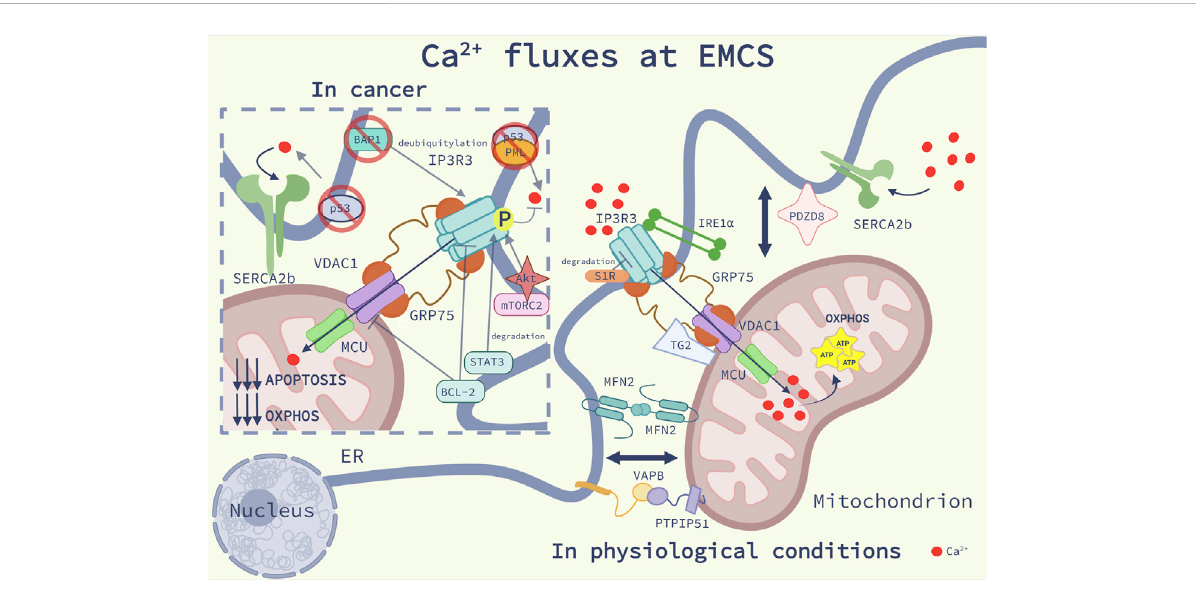
FIGURE 1 Ca2+ fl uxes at EMCS: Schematic representation of the main modulators of Ca 2+ homeostasis at ER-mitochondria contact sites (EMCS) in physiological conditions (on the right) and in cancer (on the left), as discussed in the main text. On the right side of the image, are represented the main Ca 2+ regulatory systems at EMCS: the inositol 1,4,5-trisphosphate receptors 3 (IP3R3)- glucose-related regulated protein 75 (Grp75)-voltage- dependent anion channel 1 (VDAC1) signaling complex, delivering Ca2 + to themitochondria, the Ca 2+ uniporter (MCU), allowing Ca 2+ entry into the mitochondrial matrix, and the sarco/endoplasmic reticulum Ca 2+ ATPase 2b (SERCA2b), which pumps Ca 2+ from the cytosol to the ER. Maintenance of mitochondrial Ca 2+ homeostasis through the integrity of the EMCS, promotes mitochondrial bioenergetics. Sigma-1Receptor (S1R) binds to IP3R3 and decreases its degradation; the ER stress sensor Inositol-requiring enzyme 1 (IRE1 α ) interacts and brings IP3R3 at EMCS. Transglutaminase type 2 (TG2) binds to Grp75 and promotes mitochondrial Ca 2+ uptake. The complex formed by the protein tyrosine phosphatase interacting protein 51 (PTPIP51) and the vesicle-associated membrane protein-associated protein B (VAPB), PDZ domain-containing protein 8 (PDZD8) and Mitofusin 2 (MFN2) homodimers favor Ca 2+ fl uxes by regulating the EMCS proximity. On the left side of the image we describe Ca 2+ dysregulation in cancer. The tumor suppressor p53 at EMCS binds to SERCA pump preventing its ROS-mediated inactivation. P53 interacts with promyelocytic leukemia (PML) protein, promoting the dephosphorylation and inactivation of the proto-oncogene serine/threonine kinase Akt, which together with the Rapamycin complex 2 (mTORC2) phosphorylate and inhibit IP3R3. The proto-oncogene B-cell lymphoma 2 (Bcl-2) interacts and inhibits VDAC1 and IP3R3 suppressing Ca 2+ fl uxes. IP3R3 stability is regulated by the oncogenic signal transducer and activator